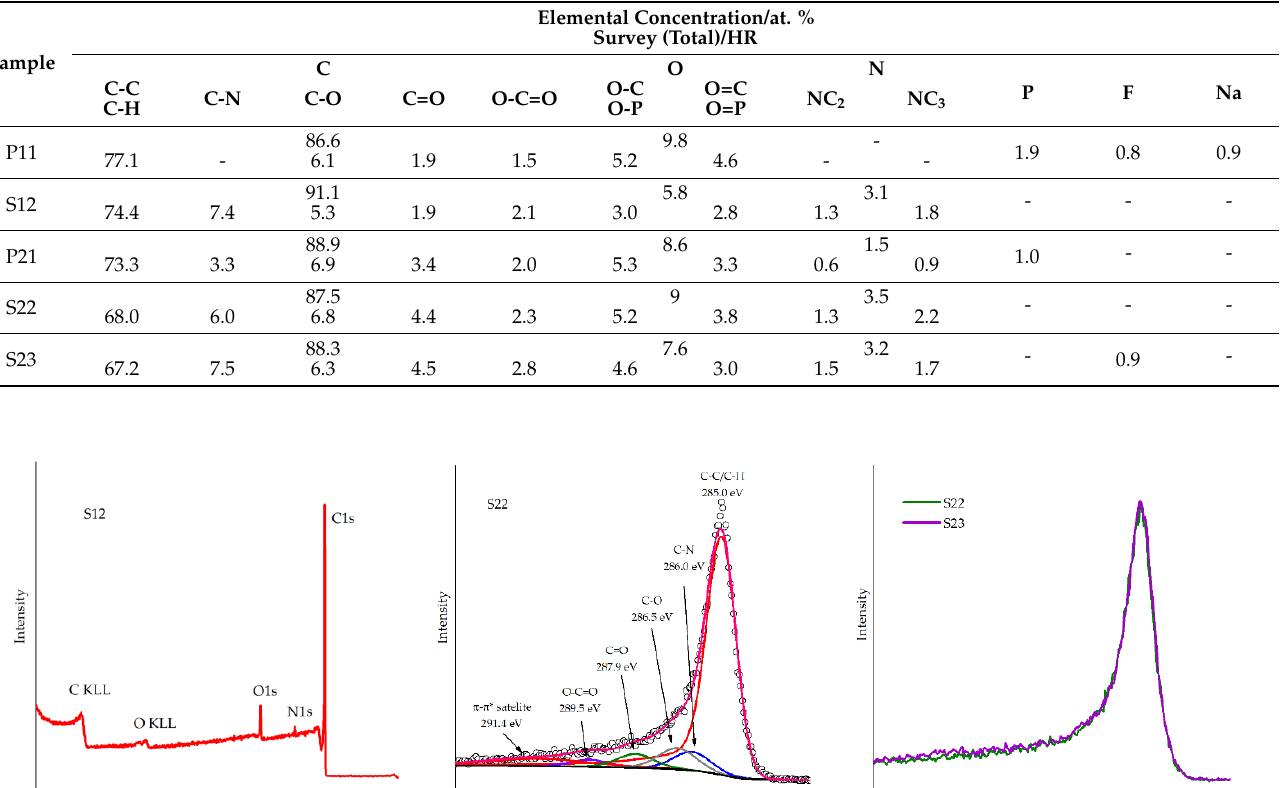
Table 3. Elemental and chemical composition of the prepared CFs from the XPS analysis.